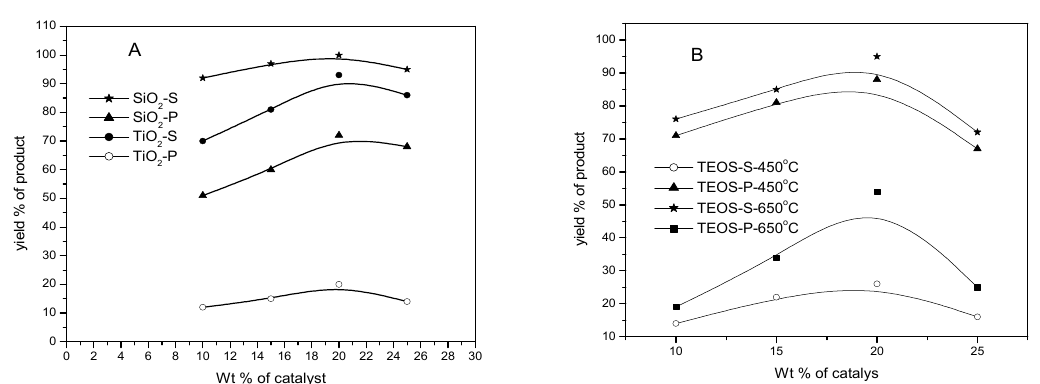
Scheme 1. Pechmann reaction.